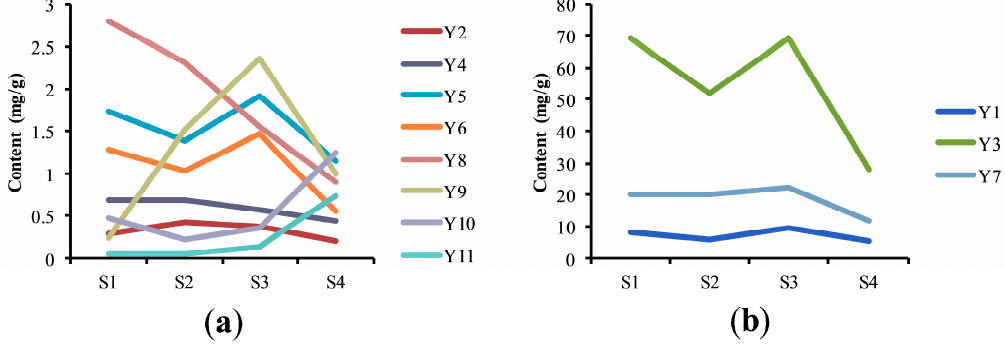
Figure 6. Changes in content of the eleven constituents in four different growth periods: ( a ) Y 2 /Y 4 /Y 5 /Y 6 /Y 8 /Y 9 /Y 10 /Y 11 ; ( b ) Y 1 /Y 3 /Y 7 .